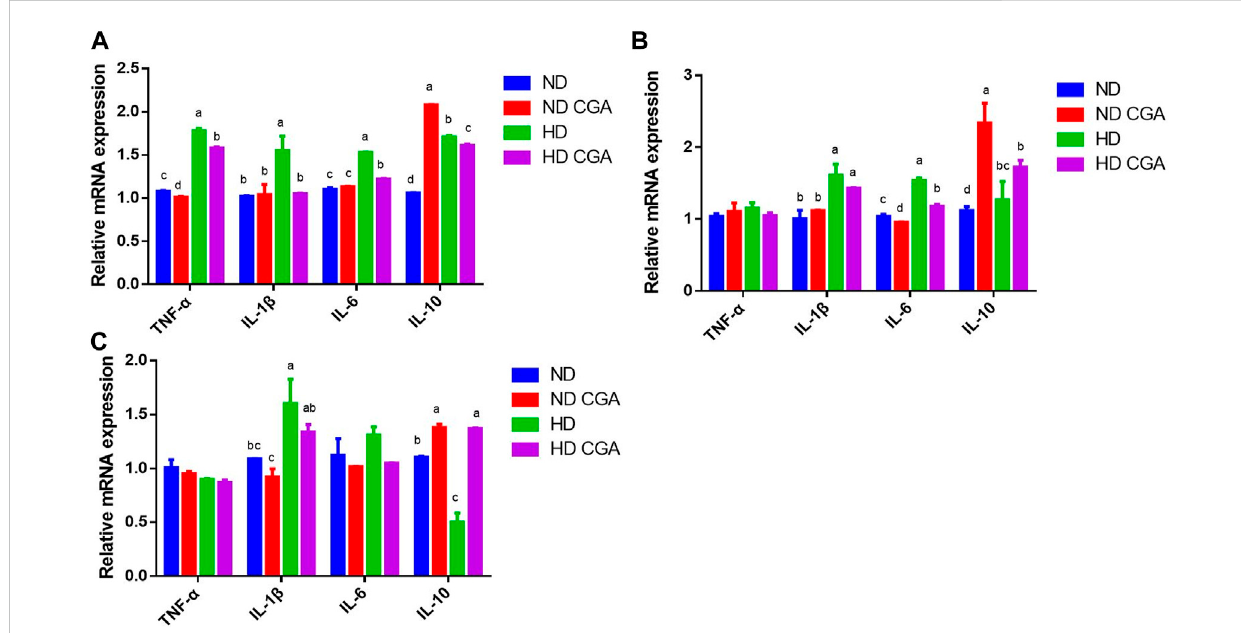
FIGURE 3 EffectsofCGAonileummRNAexpressionofimmunefactorsinbroilersunderHDstress.NDgroup,normalstockingdensity+basaldiet;ND+CGA group,normalstockingdensity+basaldiet+0.15%CGA;HDgroup,highstockingdensity+basaldiet;HD+CGAgroup,highstockingdensity+basaldiet +0.15% CGA. (A) Relative mRNA expression at day 28. (B) Relative mRNA expression at day 35. (C) Relative mRNA expression at day 42. Each vertical bar represents the mean ± SEM ( n = 10). Values with different letters within the same row are indicative of statistically signi fi cant differences ( p < 0.05, Tukey ’ s HSD test after one-way